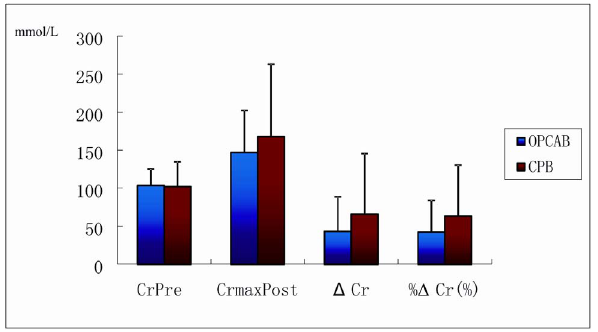
Figure 1. Changes of CrPre, Cr max Post, D Cr and % D Cr in Patients with ARAS and Undergoing Cardiac surgery. ARAS: atherosclerotic renal artery stenosis; OPCAB: cardiopulmonary bypass; OPCAB: off-pump coronary bypass; CrPre: CrPre: preoperative creati- nine; CrmaxPost: peak postoperative creatinine; D Cr: difference between preoperative creatinine and postoperative creatinine; % D